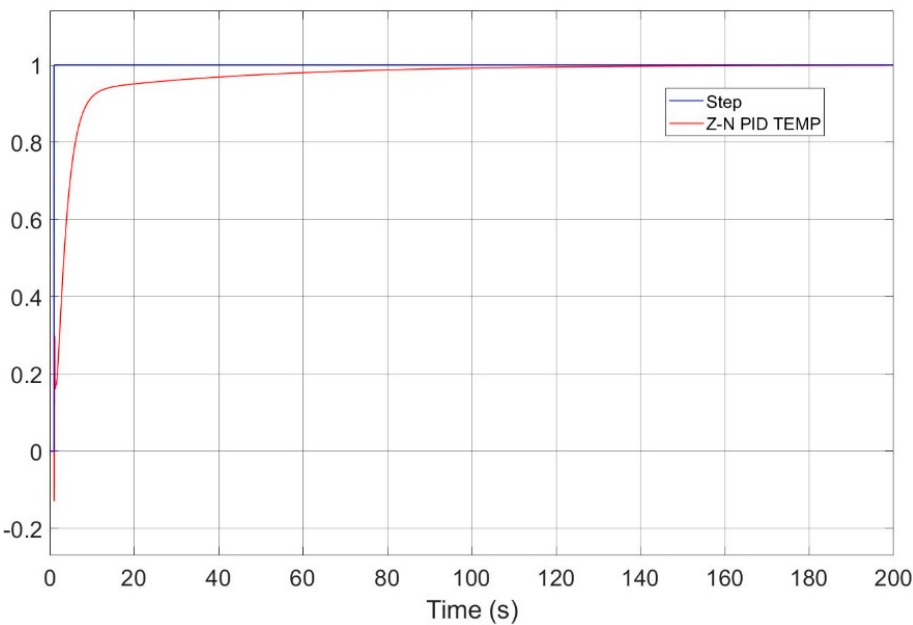
Figure 17. Temperature versus time plot for PID tuned with Zeigler–Nicholas.